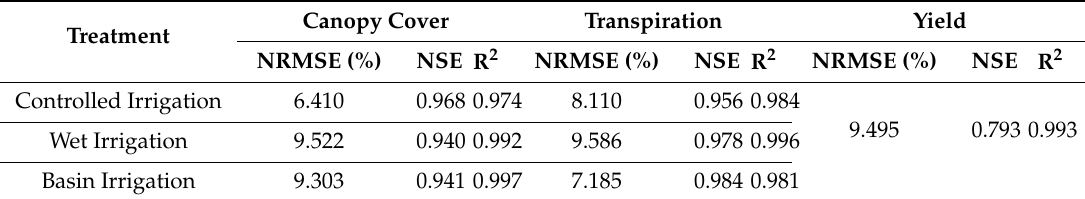
Table 3. Calibrated crop